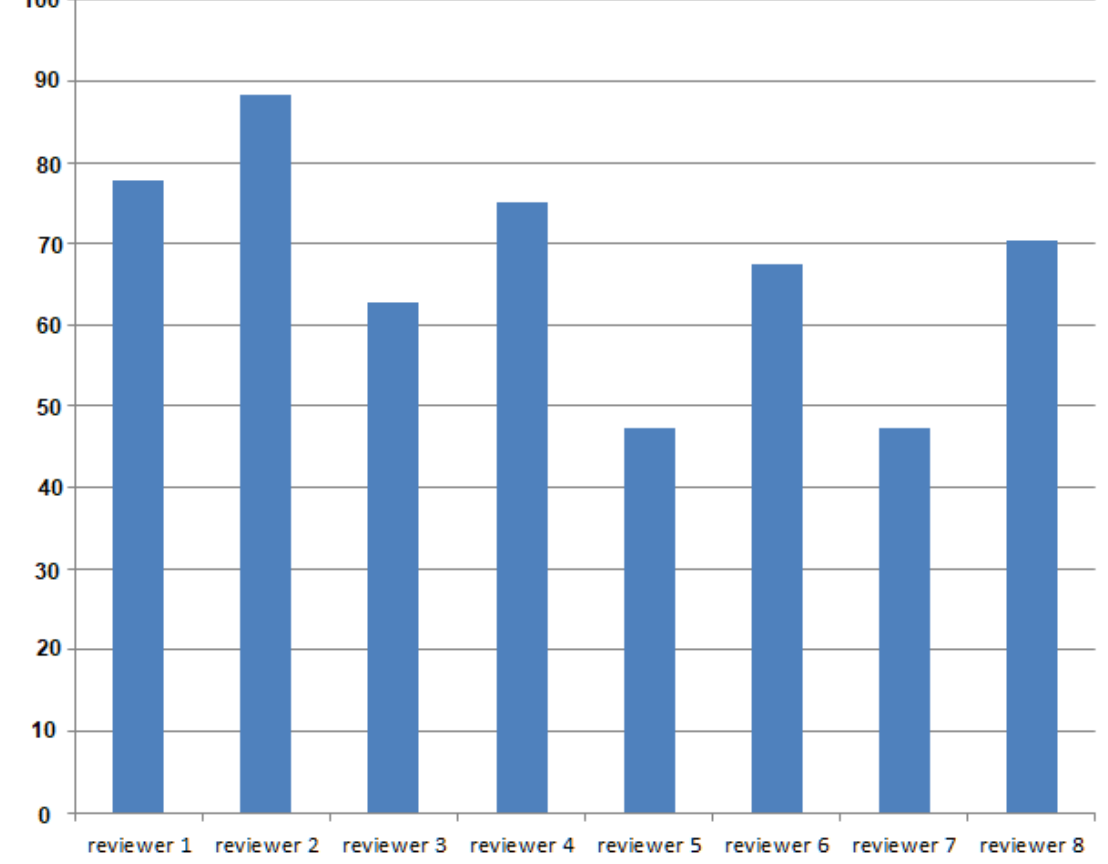
Figure 3. Variation in cVR-Both by individual experts as calculated by the random effects bivariate probit model.